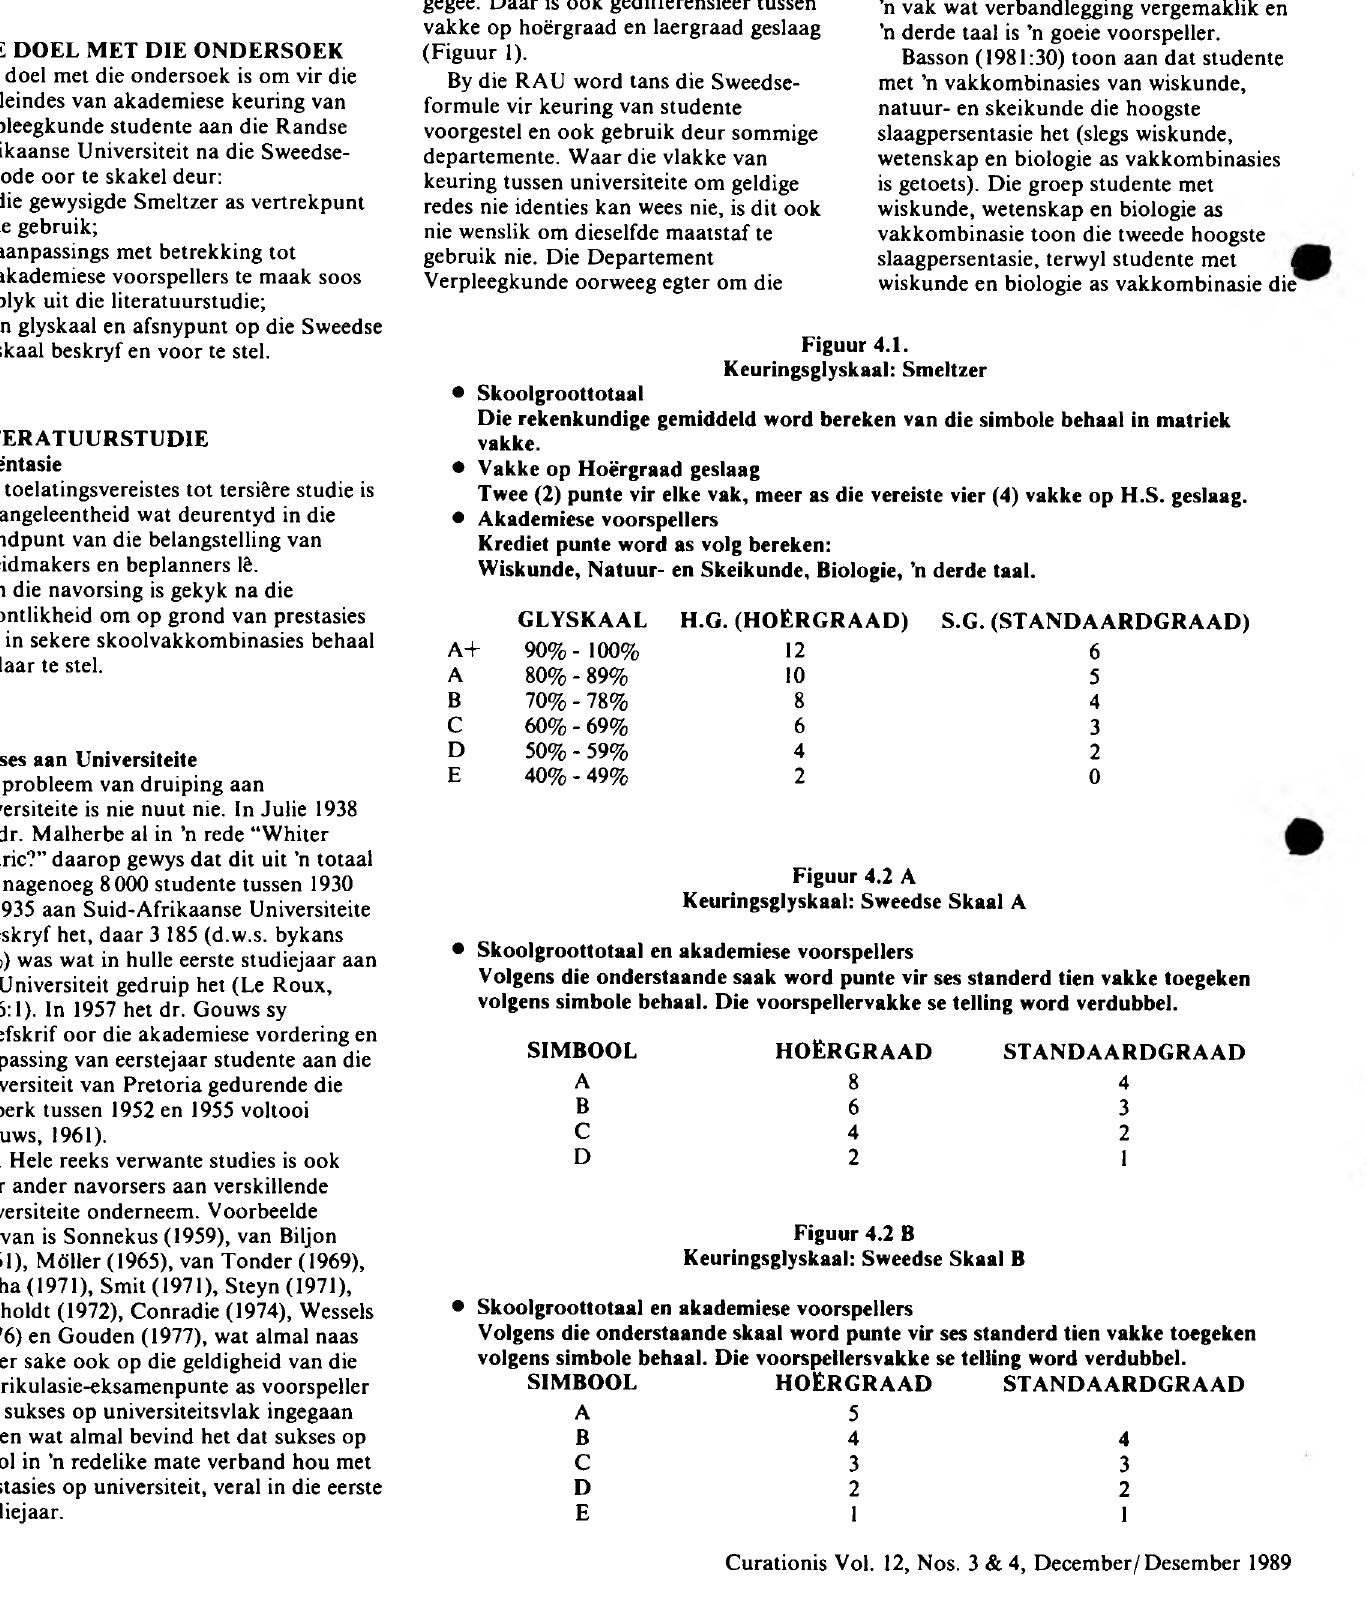
Figuur 4.2 B Keuringsglyskaal: Sweedse Skaal